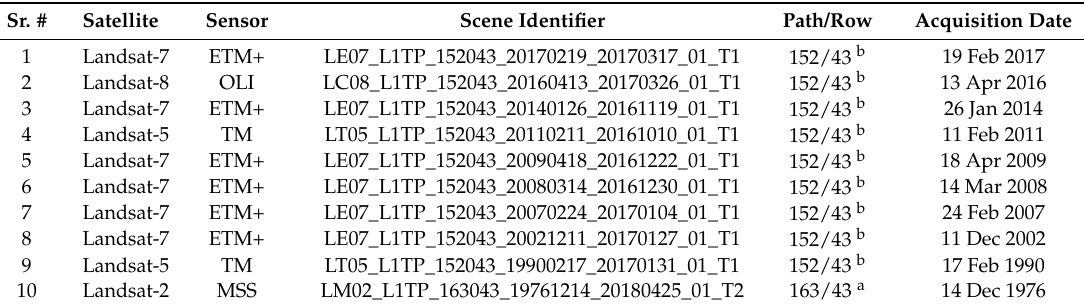
Table A1. List of Landsat images used in this